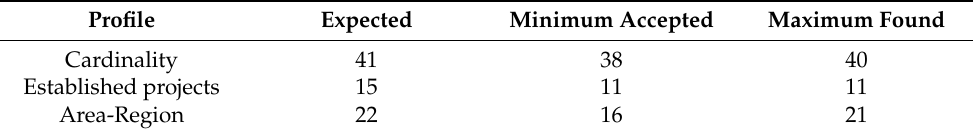
Table 3. DM’s profile characterization and maximum found values.